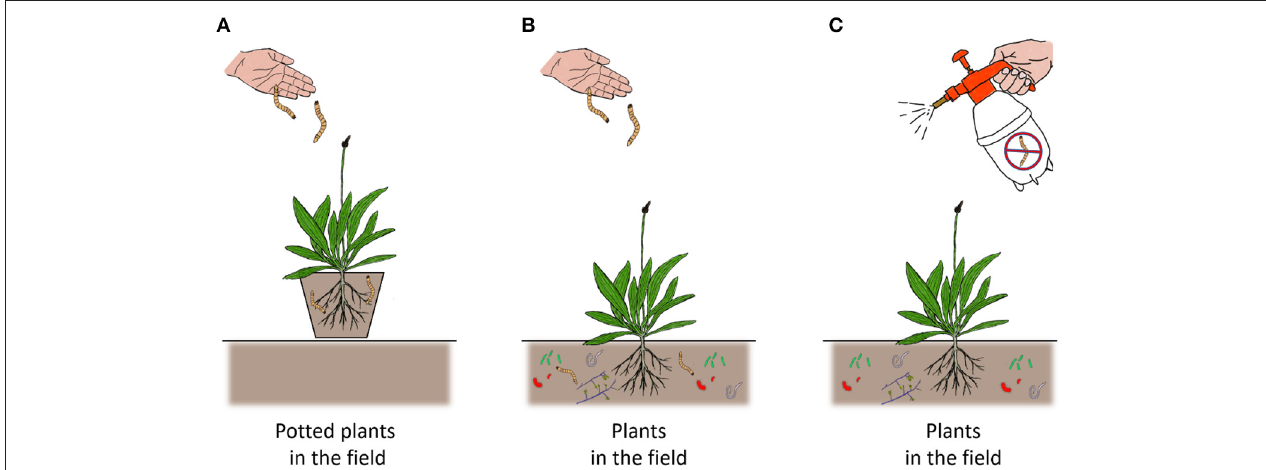
FIGURE 3 | A schematic overview of the three most widely used methodologies to investigate soil biota-plant-insect interactions in the field. In this representation we used additions of wireworms, Agriotes spp. to Ribwort plantain Plantago lanceolata as an example. (A) Potted plants, which are often grown in a greenhouse for a number of weeks, are placed in experimental fields or gardens after being treated with soil organisms. Interactions between the potted plants and natural herbivores or pollinators are then tested in the field. (B) Plants are planted in the field under natural conditions, including a resident soil community. Soil organisms are added to plots and thus in the treated plots the numbers of added soil organisms are augmented, compared to untreated control plots. (C) Plants are planted in the field under natural conditions, including a resident soil community. However, in this method, the soil organisms under investigation are reduced by means of application of a pesticide. Hence, the treated plots have reduced levels of soil organisms, compared to the control plots, which have natural (but higher) levels of the soil